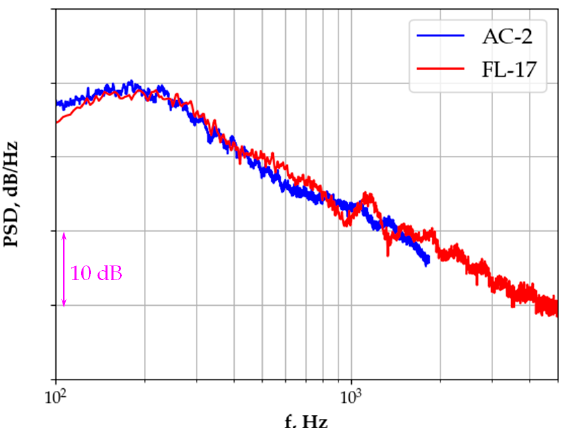
Figure 13. Comparison of the normalized spectra of the four-wheel landing gear model with the high main leg. Flow speed is 75 m s − 1 . Microphone is at ( θ , φ ) = (90°, 20°). main leg. Flow speed is 75 m s − 1 . Microphone is at ( θ , ϕ ) = (90 ◦ , 20 ◦ ).